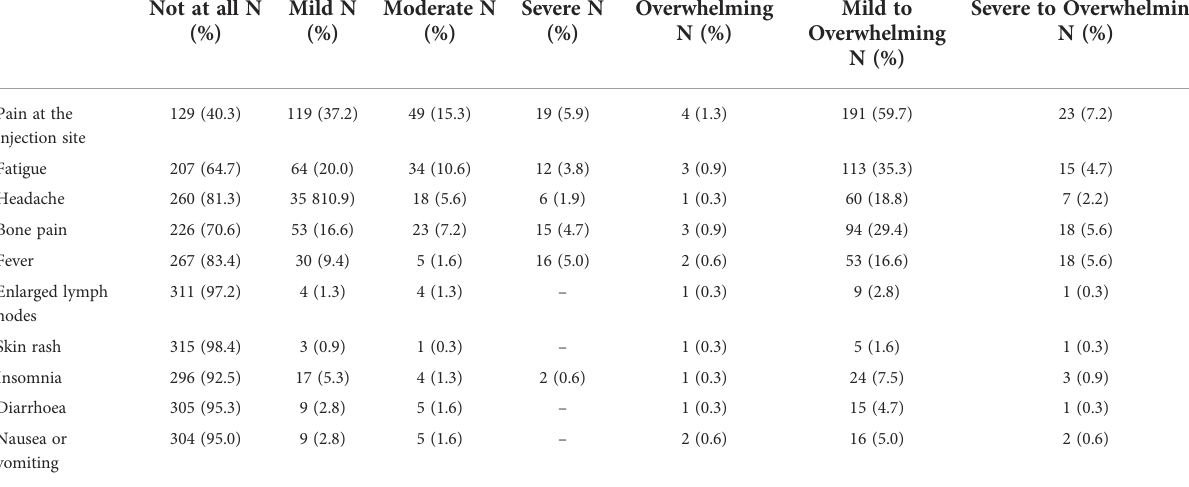
TABLE 3 Vaccine-related reactions over the week after the third (booster)